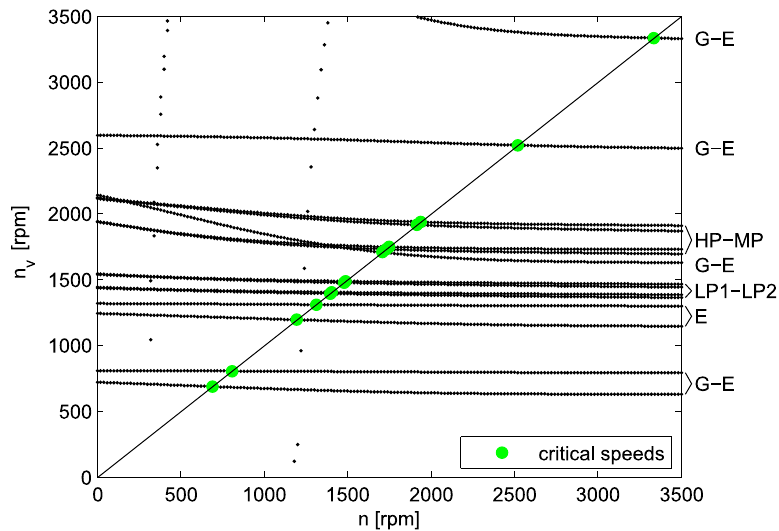
Figure 9. The Campbell diagram calculated using model A (the rotor with bearings mounted to the rigid ground).